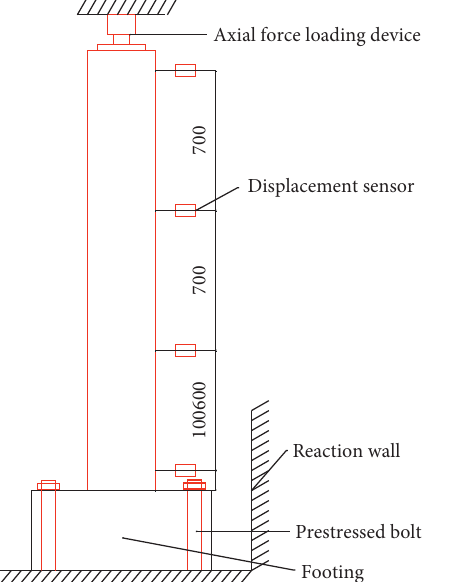
Figure 5: Diagram of displacement measurement points (unit: mm).